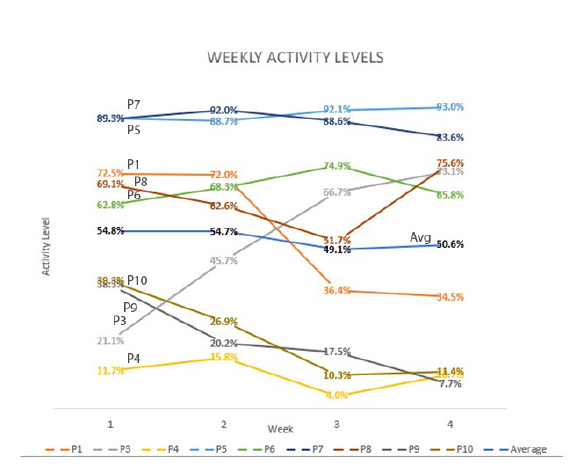
Figure 2: Weekly activity (interaction) percent per participant, as registered by sensors on the robot’s collar. The average across all participants is shown in the middle of the graph, in